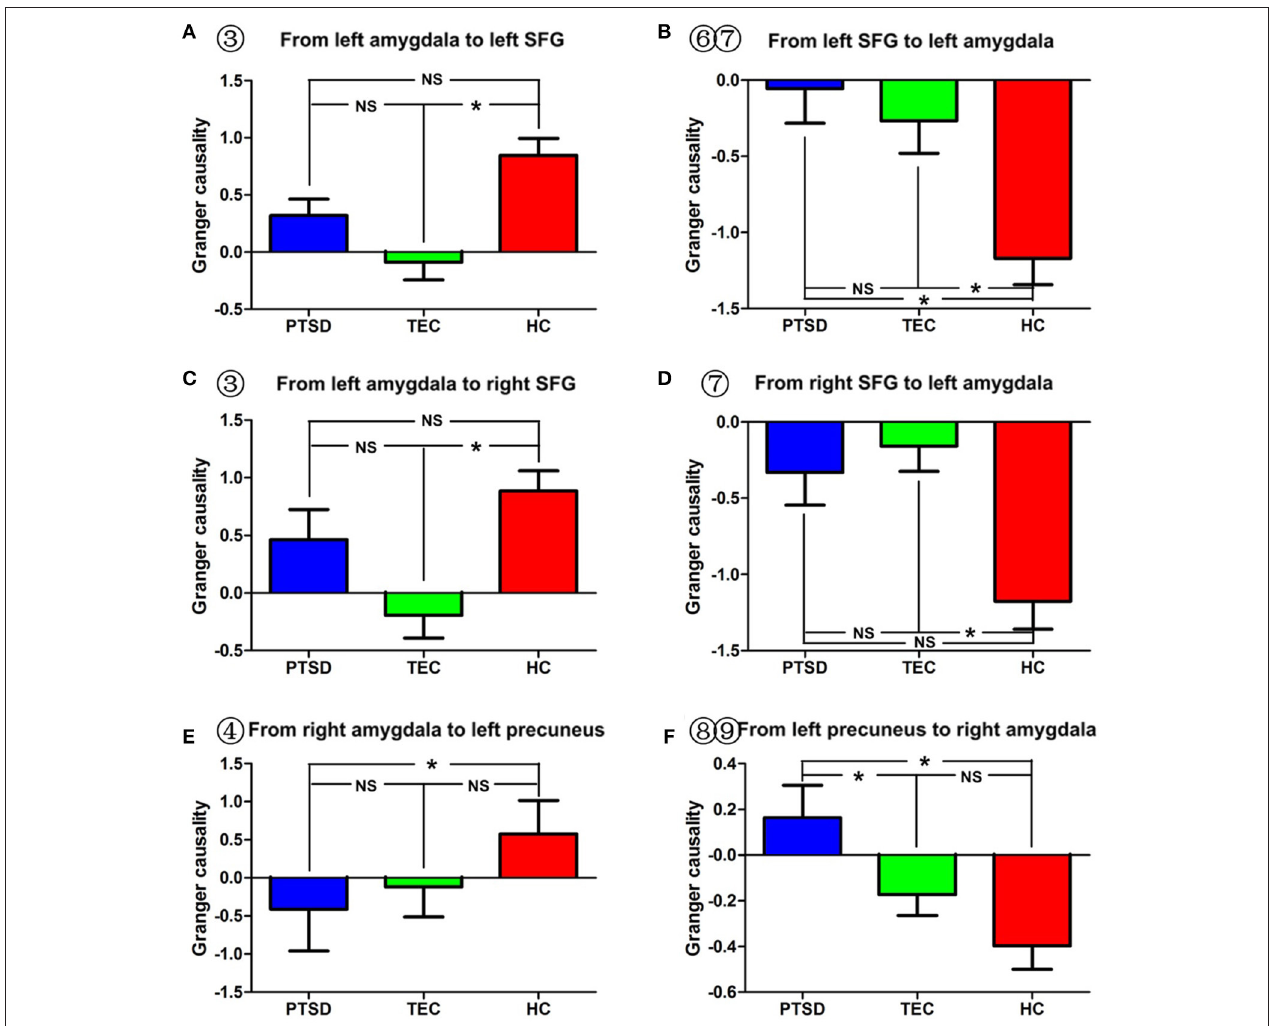
FIGURE 4 | Comparison of effective connectivity between the amygdala and the superior temporal gyrus and between the amygdala and the precuneus. (A–D) Show inter-group differences regarding the influence of the amygdala on the superior temporal gyrus and the influence of the superior temporal gyrus on the amygdala. (E,F) Indicate inter-group differences regarding the influence of the amygdala on the precuneus, and the influence of the precuneus on the amygdala. PTSD, post-traumatic stress disorder group; TEC, trauma-exposed control group; HC, healthy control group; SFG, superior frontal gyrus. “*” means having significant difference between the two